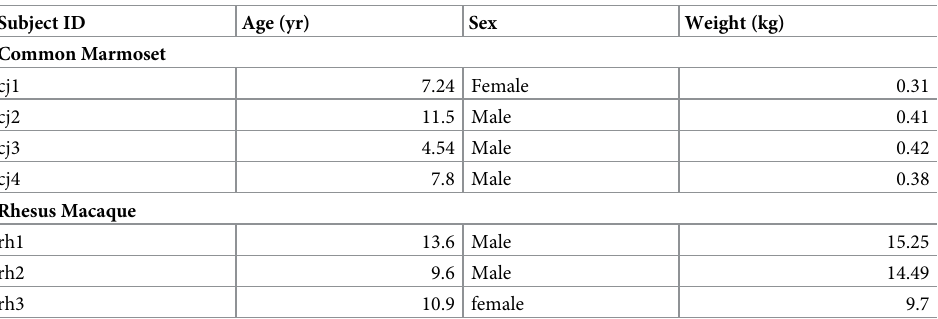
Table 1. Demographics of NHPs used in this